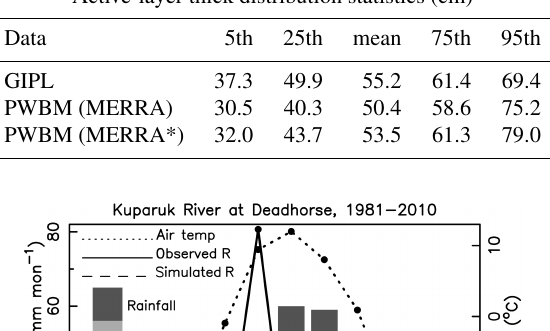
Table 1. Distribution statistics (cm) for spatial fields of active- layer thickness (ALT) from the GIPL and PWBM simulation with MERRA* forcing shown in Fig. S3. Also shown are statistics for a simulation using original (non adjusted) MERRA precipitation ( P ) data.